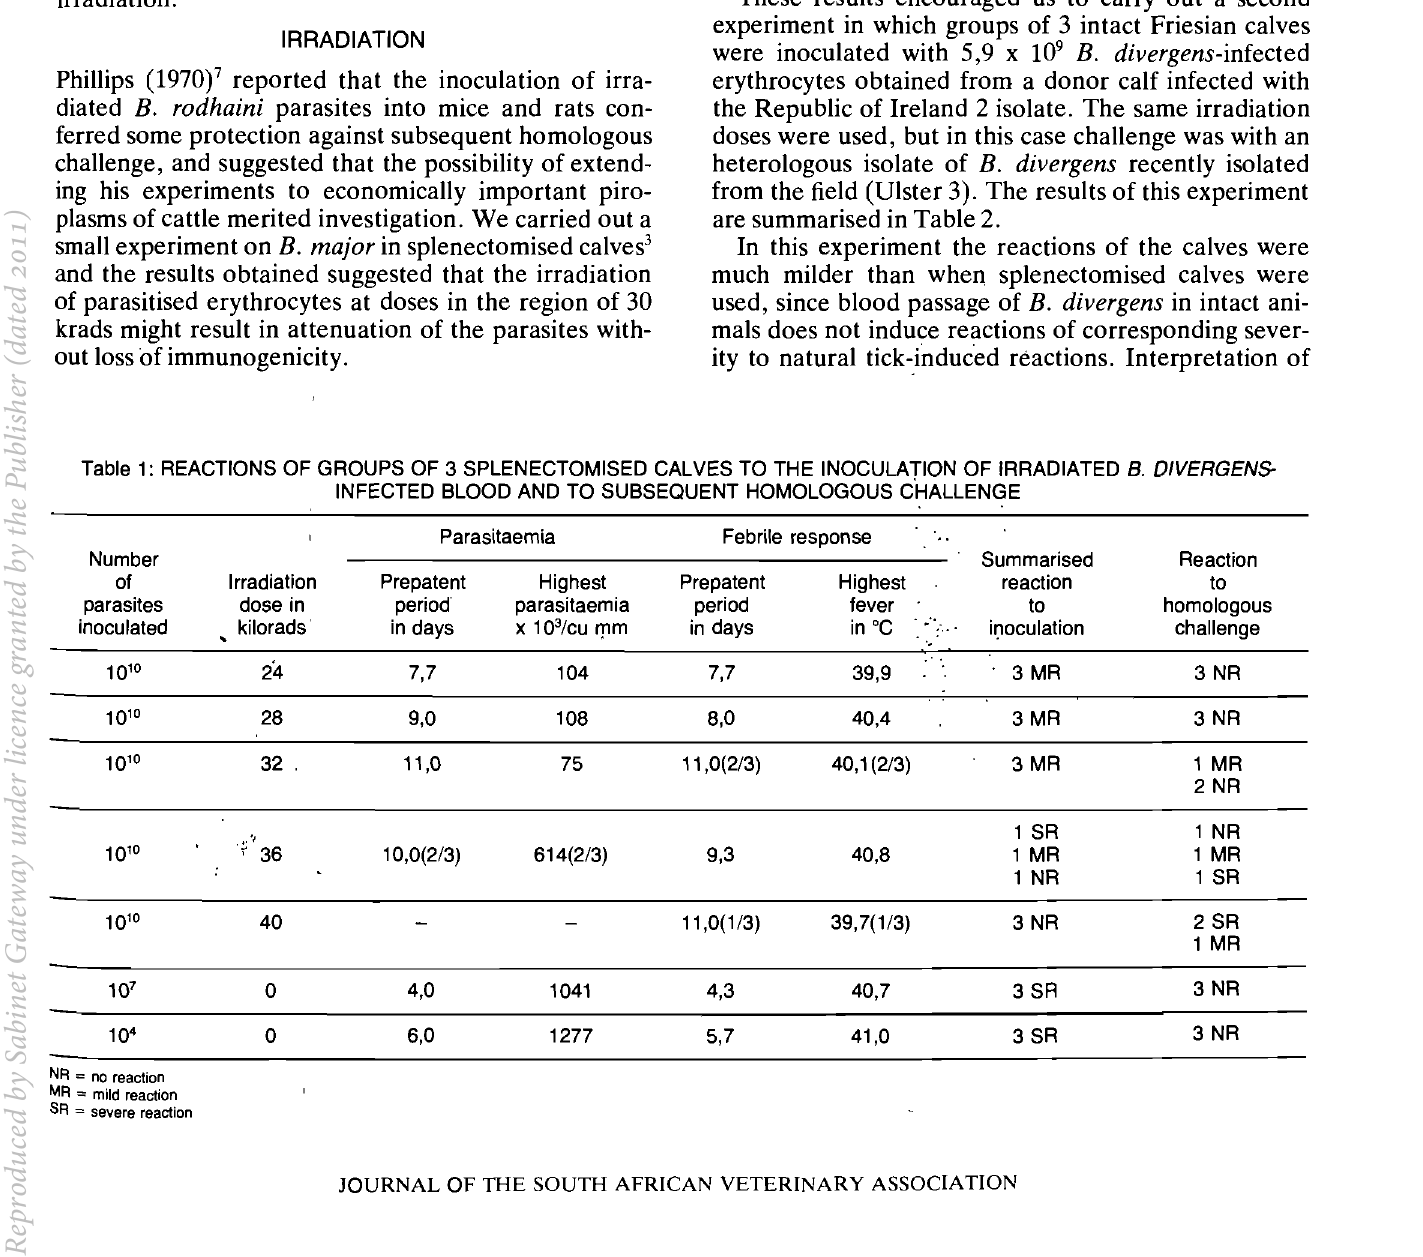
Table 1: REACTIONS OF GROUPS OF 3 SPLENECTOMISED CALVES TO THE INOCULATION OF IRRADIATED B. DIV£RG£N5- INFECTED BLOOD AND TO SUBSEQUENT HOMOLOGOUS C'HALLENGE